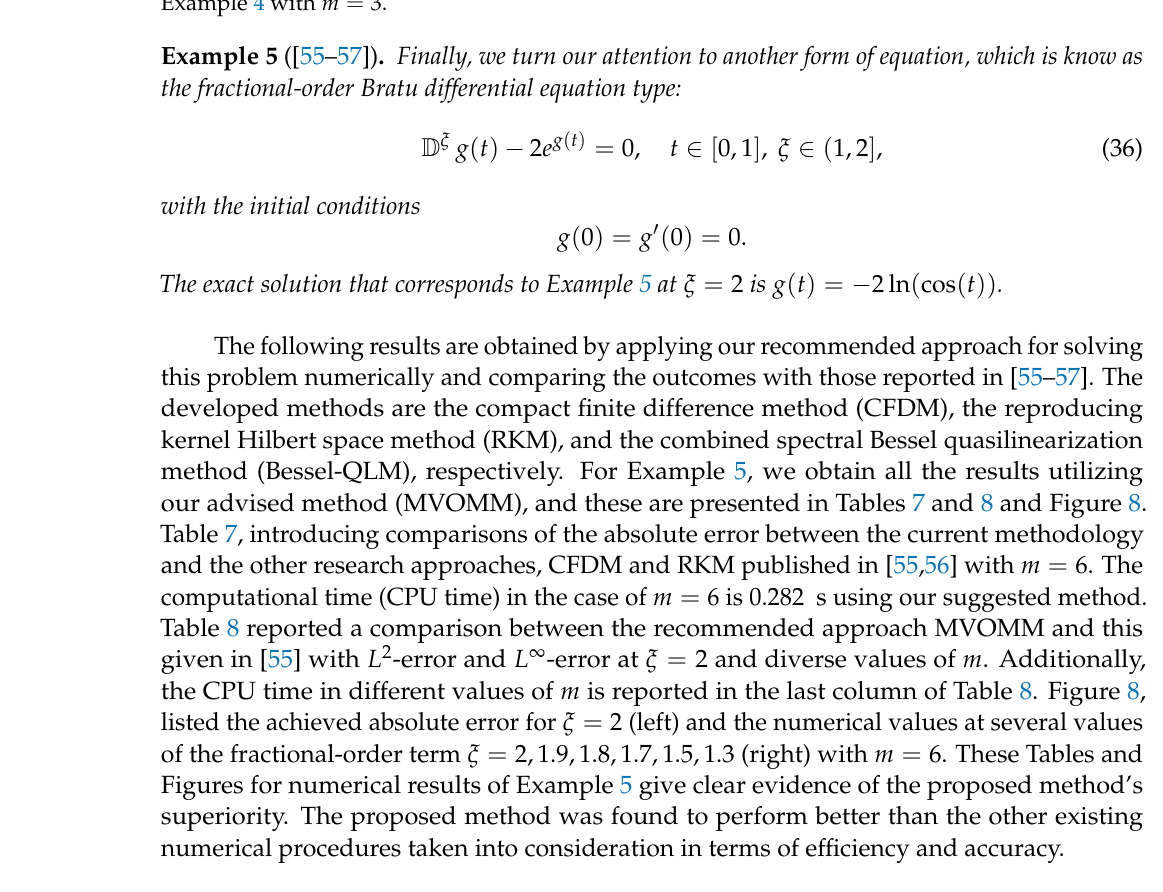
Table 7. Comparison of the absolute inaccuracy between the MVOMM and the CFDM and RKM used in the previous studies [55–57] using ξ = 2 for Example